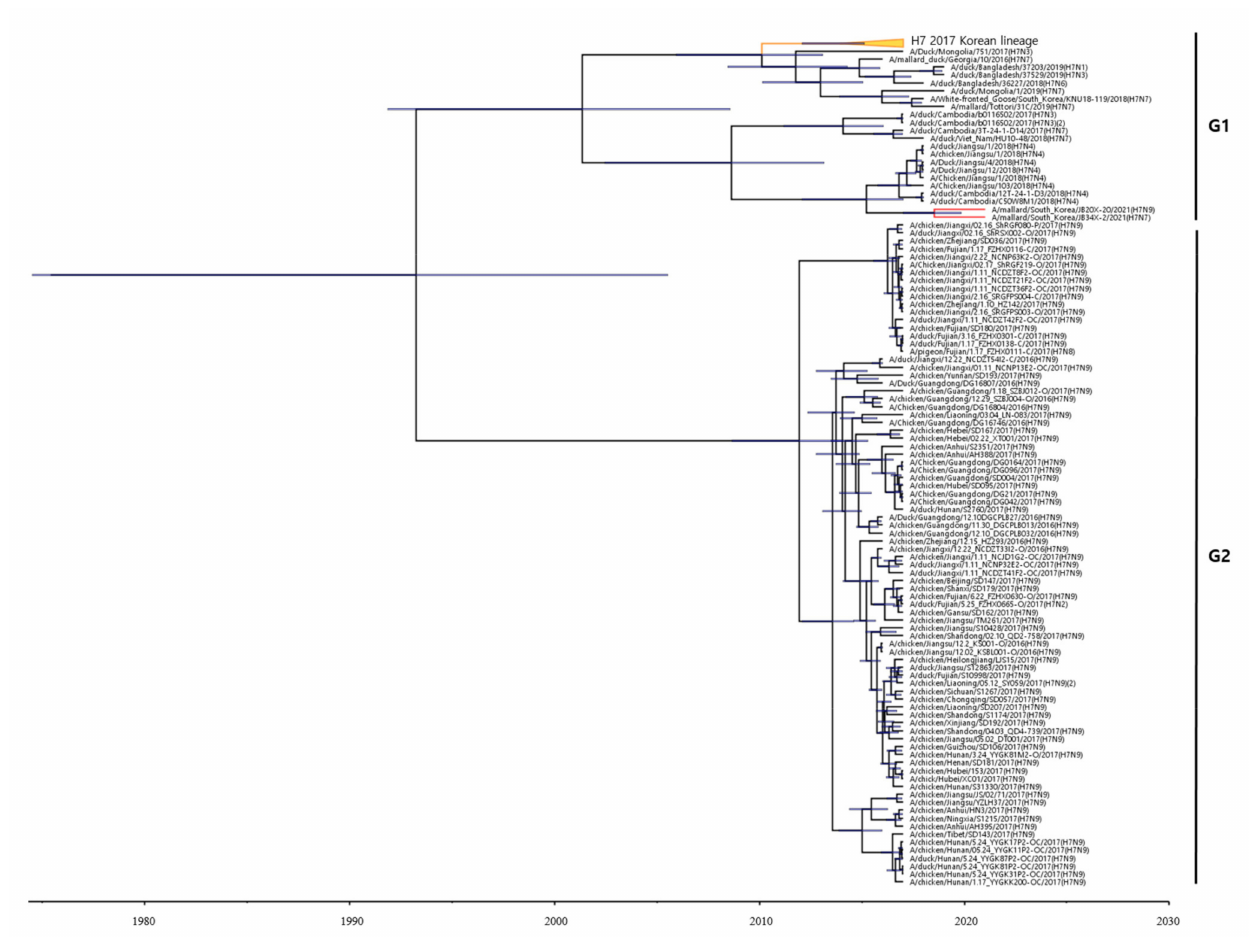
Figure 2. Maximum clade credibility (MCC) trees of the HA gene of H7 LPAIVs isolated between 2016 and 2021 in Asia. The MCC tree were constructed using the uncorrelated lognormal distribution relaxed clock method in BEAST v1.10.4. The ESS values were greater than 200. Posterior probabilities >0.8 are provided in the tree. The horizontal axis indicates the time scale, and the unit is 10 years. The two H7 Korean AIVs are shown in red. The H7 LPAIVs circulating in South Korea in 2017 are shown in orange.